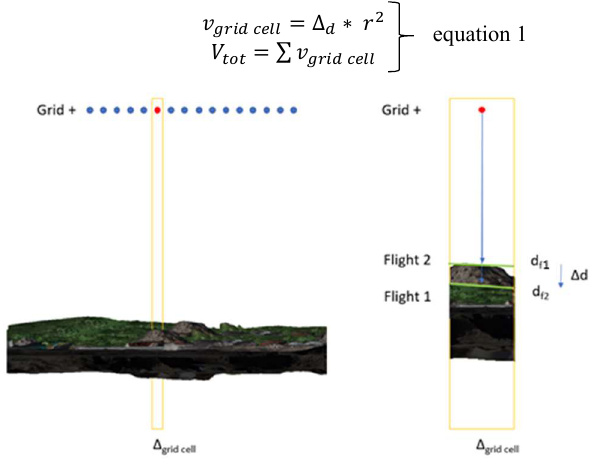
Figure 7: Visualisation of the volume calculation methodology between two epochs.